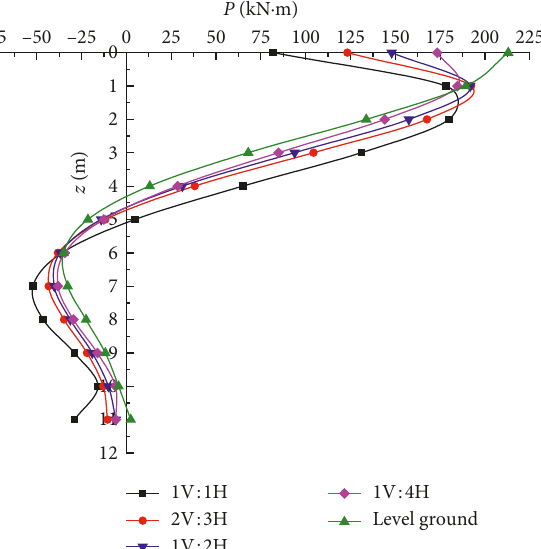
Figure 12: Lateral soil resistance versus depth relationships of 500kN. different slope ratios for H 0 (cid:31)